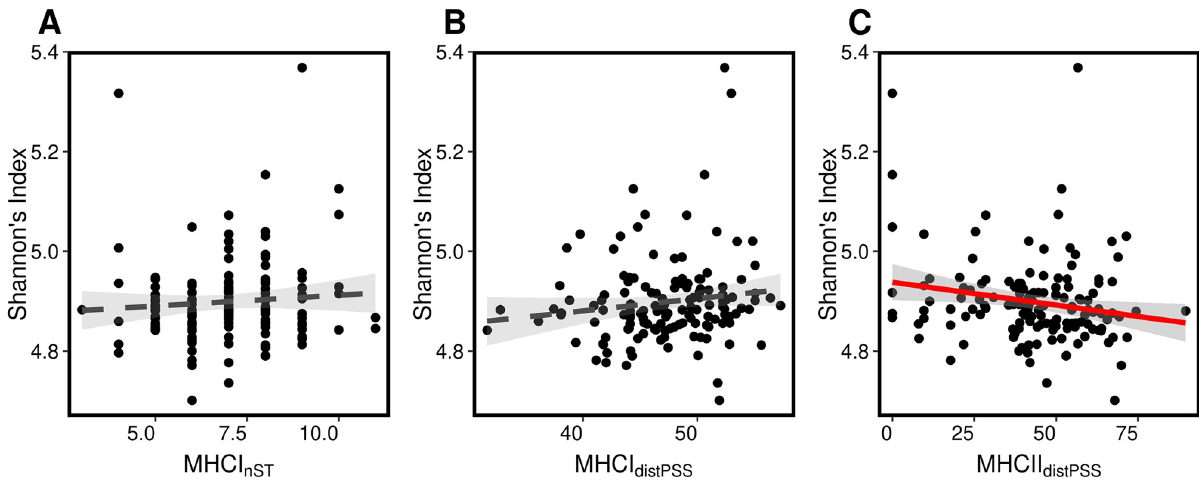
Fig 5. MHC is associated with functional diversity of the microbiome. Relationship between (A) number of MHCI supertypes, (B) MHCI sequence divergence and (C) MHCII sequence divergence and the functional diversity of the microbiome according to Shannon’s diversity index. Associations supported by model selection ( Δ AIC > 2) are reported with a red solid line, shaded area represent 95% confidence intervals. Dashed lines represent non-significant trends.